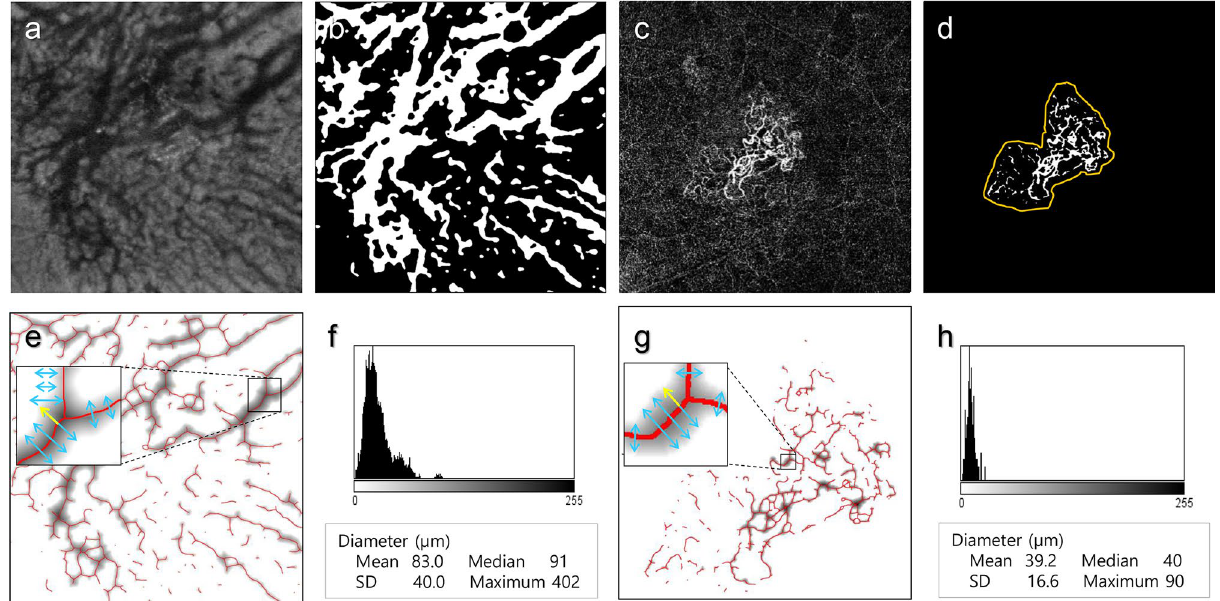
Figure 4. Quantitative measurement of various vessel-related parameters. ( a ) En face image of the Haller vessel structure in an eye with age-related macular degeneration. ( b ) Binarized en face image of a Haller vessel obtained via the Phansalkar binarization method using FIJI software. The vessel area was measured by counting white pixels. ( c ) En face morphology of macular neovascularization (MNV) was observed using optical coherence tomography angiography in the same eye. ( d ) Binarized image of MNV obtained using Weka binarization. The MNV area was calculated from the area inside the MNV boundary (orange-colored line), while the vessel area was measured by counting white pixels inside the MNV boundary. ( e ) The diameter of the en face Haller vessel was calculated using the DiameterJ plugin in FIJI. When the binarized vessel image of ( b ) is loaded, the DiameterJ plugin measures the distance between the vessel border (i.e., vessel diameter, blue arrows in inlet) by doubling the distance from every pixel of skeletonized vessel (red line in inlet) to the closest border of vessel (yellow arrow in inlet). The grayscale image along the skeletonized vessel represents the diameter of the vessel along the centerline of the vessel. The darkness of the gray-colored area along the centerline of the vessel denotes the distance to the nearest background pixel, which is proportional to the vessel diameter at that pixel point. ( f ) Histogram showing the distribution of diameters at each point on the centerline of the vessel. The X-axis is proportional to the diameter, and the Y-axis shows the frequency of each diameter. After repetitive measurement of vessel diameter at each pixel on the centerline of vessel, the sum of total diameter values are divided by the pixel numbers of the skeletonized vessel to calculate the mean diameter. Additionally, the median, maximum and standard deviation of vessel diameter can be calculated from these data, including multiple diameter values along the centerline of the vessel. ( g ) The diameter-associated parameters of the en face MNV were calculated using the same methods applied to the Haller vessel image, ( e ) and ( f ), using the DiameterJ plugin in FIJI. ( h ) Histogram showing the distribution of diameters at each point on skeletonized vessels of MNV. From these data, the mean, median, maximum and standard deviation of the MNV diameter can be